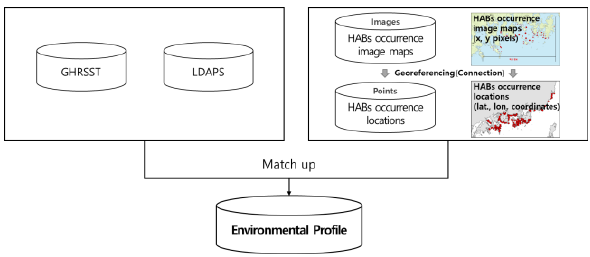
Figure 1. Dataset production process for modelling Georeferencing is method that the internal coordinate system of a map or photo image can be related to a ground system of geographic coordinates. The oceanic environment data during non red tide occurred were randomly sampled in summer data when red tide not occurred and spring, winter data when red tide occurred. In order to prevent over-fitting, dataset were divided into 80:20 and 80% were used training data. Remaining 20% were used verification (Figure 2).